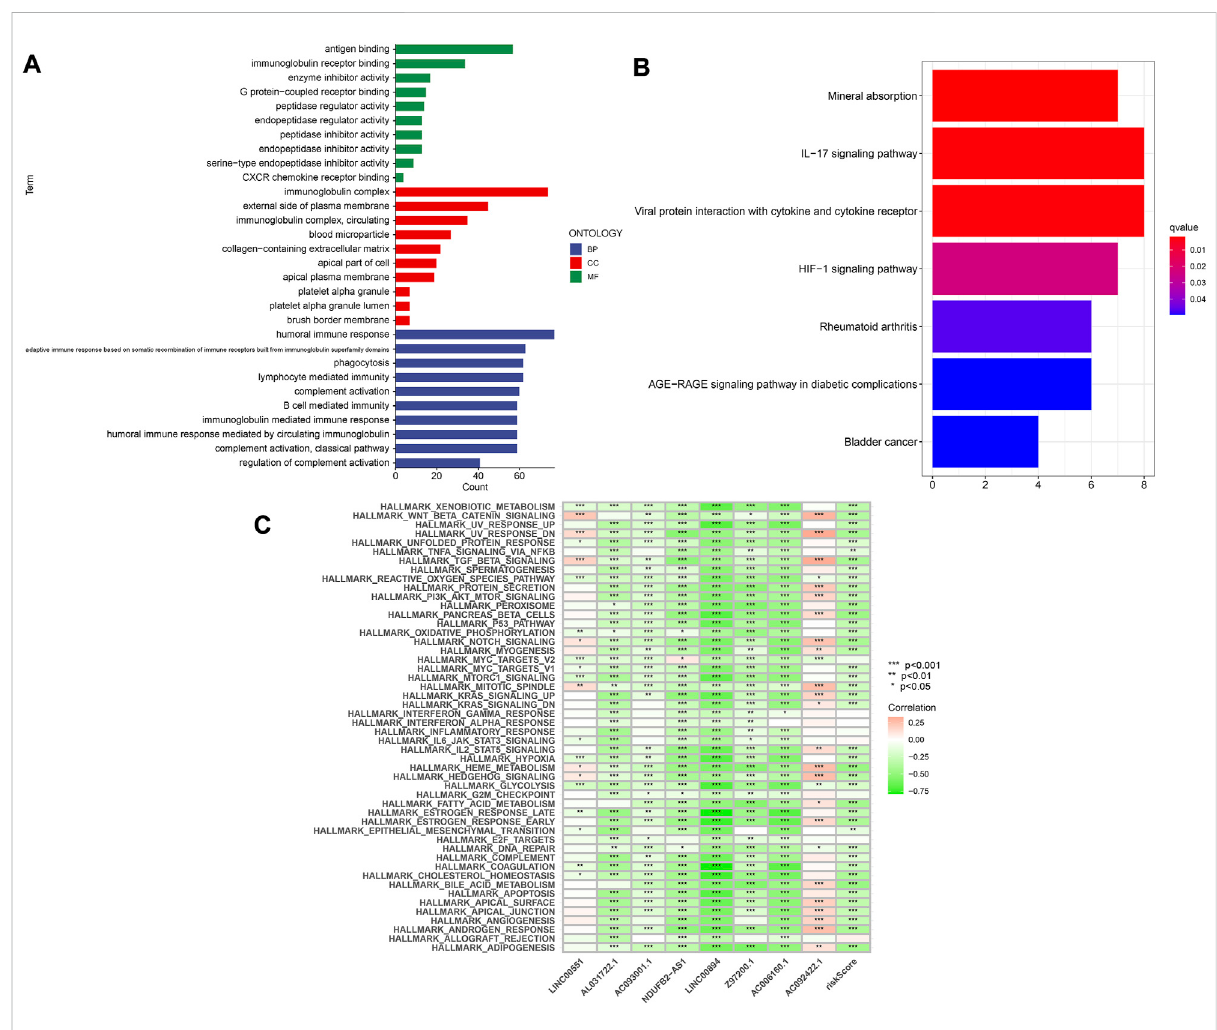
FIGURE 9 Enrichment analysis of differentially expressed genes. (A) GO analysis. (B) KEGG analysis. (C) GSVA